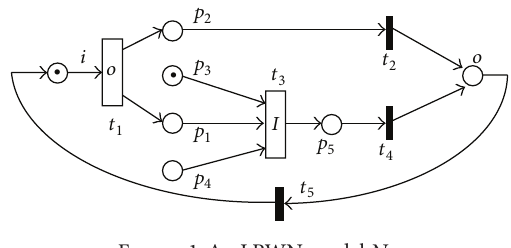
Figure 1: An LPWN model 𝑁 1